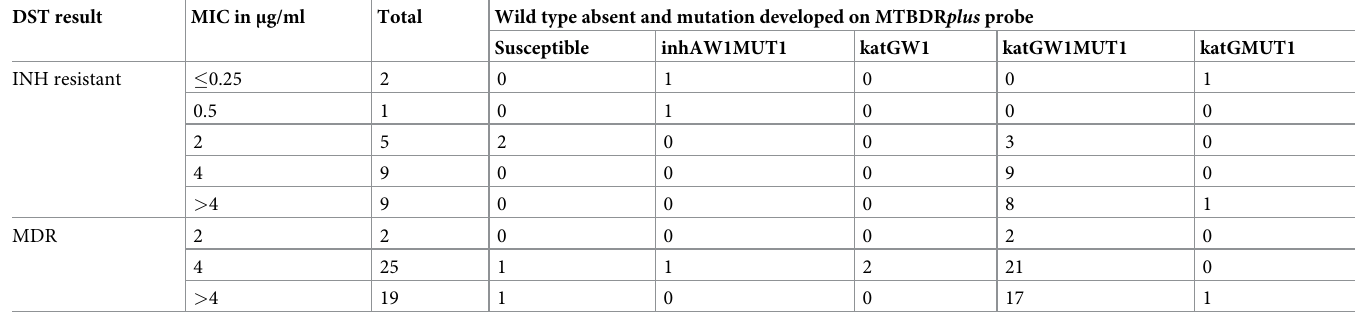
Table 3. Frequency of isoniazid resistance Mycobacterium tuberculosis isolates with minimum inhibitory concentration and line probe assay